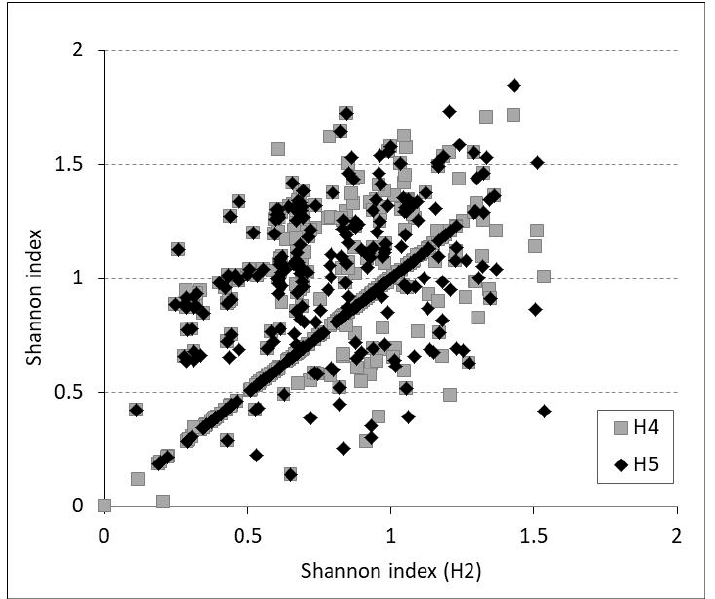
Figure 9. Relationship between diversity indices. In 49% (204) of the studied stands, it appeared that the increase in diversity in the stands in the vertical plane resulted from the increase in species diversity (H2).